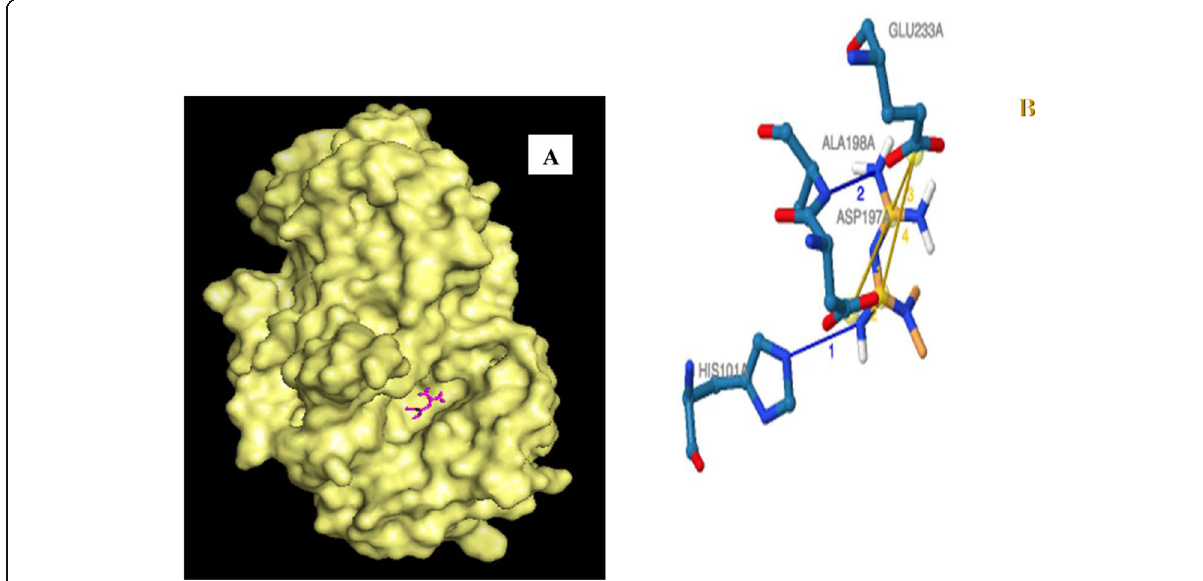
Fig. 14 Binding pose and binding site of metformin with α -amylase (panel A), molecular interaction of metformin with amino acid residues within the binding pocket of the protein structure (panel